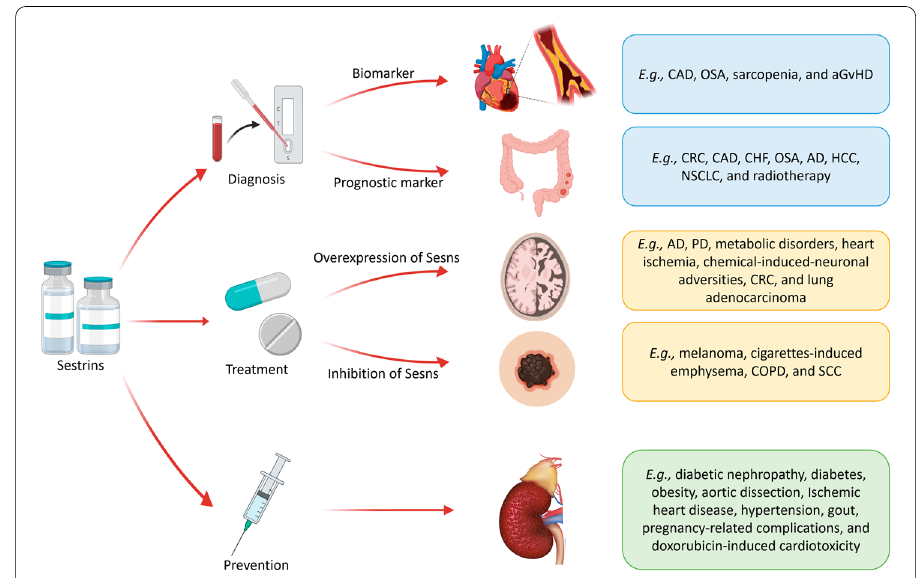
Fig. 3 Small-molecule inducers or activators targeting Sesns may be used in diagnosis, treatment, and prevention of human diseases. Sesn, sestrin; CAD, coronary heart disease; OSA, obstructive sleep apnea; aGvHD, acute graft-versus host disease; CRC, colorectal cancer; CHF, chronic heart failure; AD, Alzheimer’s disease; HCC, hepatocellular carcinoma; NSCLC, non-small-cell lung cancer; PD, Parkinson’s disease; COPD, chronic obstructive pulmonary disease; SCC, squamous cell